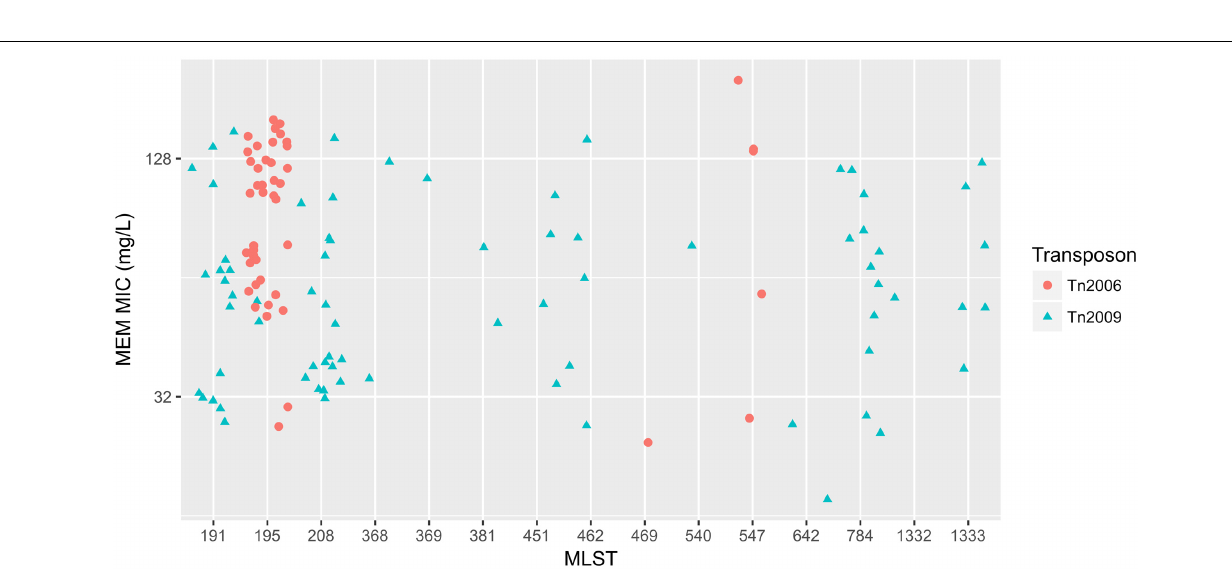
Frontiers in Microbiology |